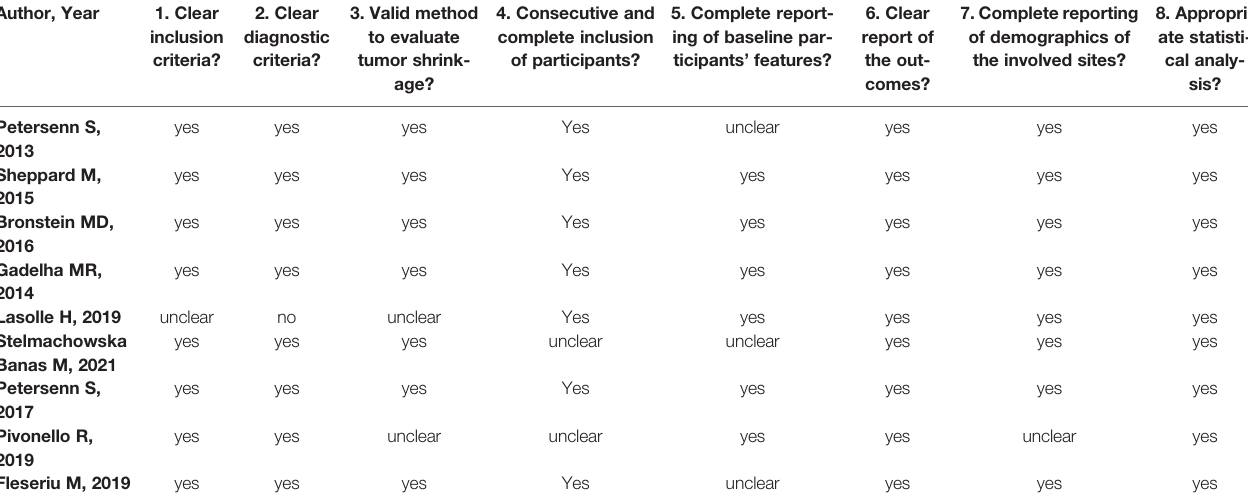
TABLE 5 | Evaluation of the risk of bias performed with the adapted Joanna Briggs ’ s Institute (JBI)